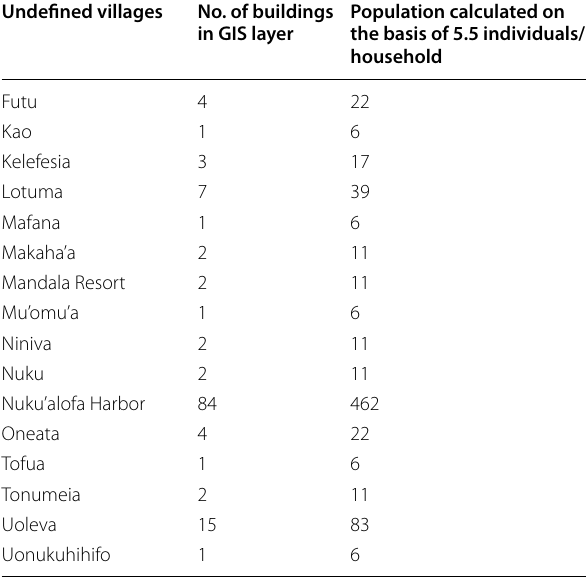
Table 2 Population estimates for undefined villages Undefined villages No. of buildings in GIS